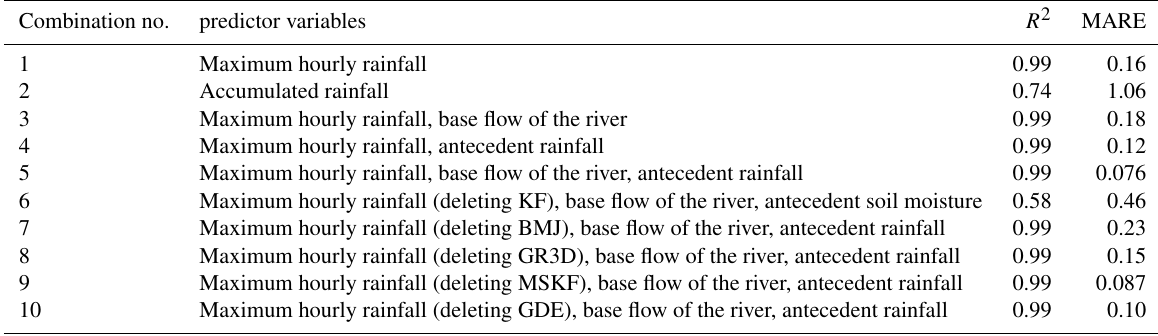
Table 3. Performance of the Bayesian network for different combinations of predictor variables. Combination no.